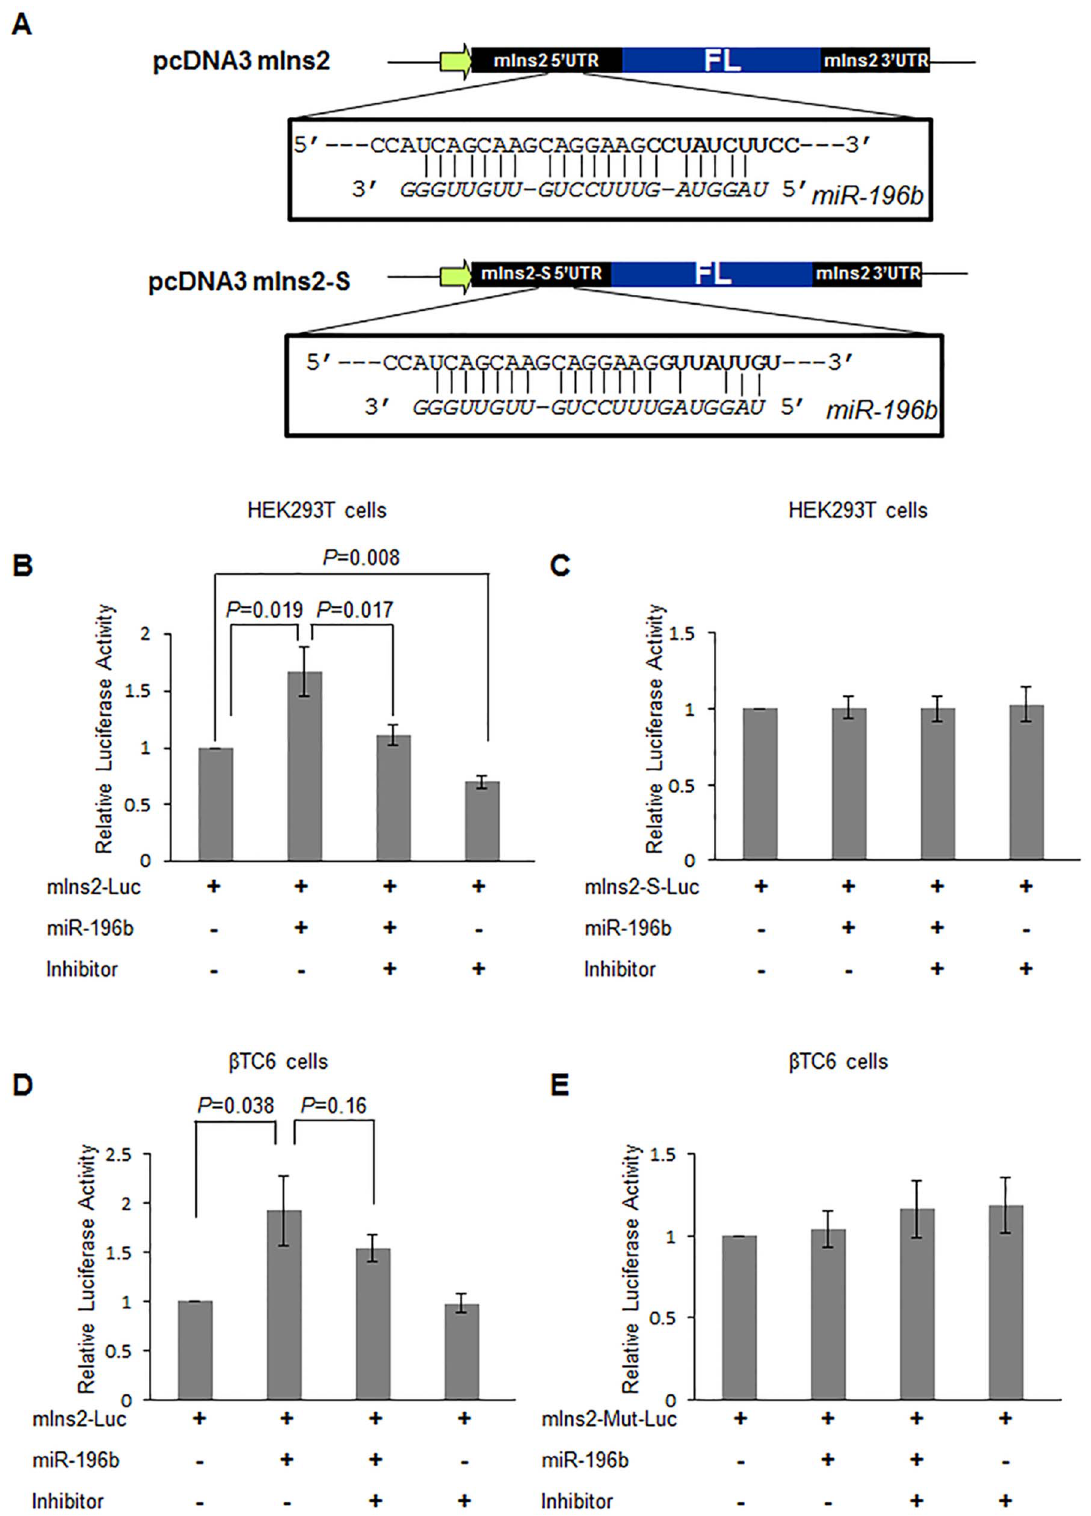
Figure 2. Translation activation mediated by miR-196b can be abolished by the anti miR-196b inhibitor. ( A ) Schematic representation of the reporter constructs for insulin2 and insulin2-S 5 9 UTR constructs. The bold letters in the RNA sequence represents the start of exon 2 of insulin2 mRNA and the lower italic letters represents the miR-196b sequence. The vertical lines between the sequences denote base pairing. ( B, C ) Anti-miR- 196b was introduced into cells along with reporter and the miRNA-pSuper; 48 hr later, the effect of the miR-196b inhibitor was analyzed by measuring the relative luciferase activity in HEK293T cells transfected with insulin2 reporter (B) or insulin2-S reporter (C). ( D, E ) The miR-196b inhibitor and miR-196b duplex/control miRNA were introduced into b TC6 cells before transfecting with insulin2-luciferase reporter (D) or the mutant-reporter